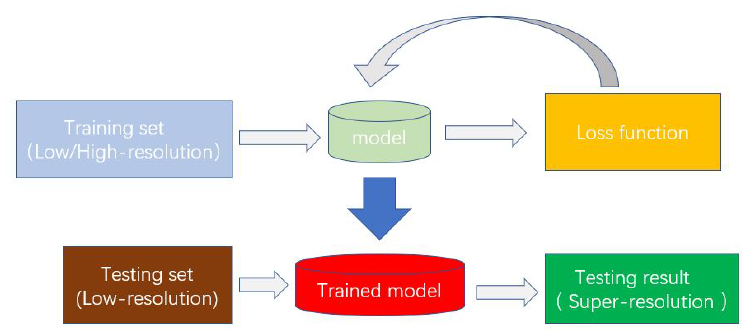
Figure 2. The process of super-resolution using deep